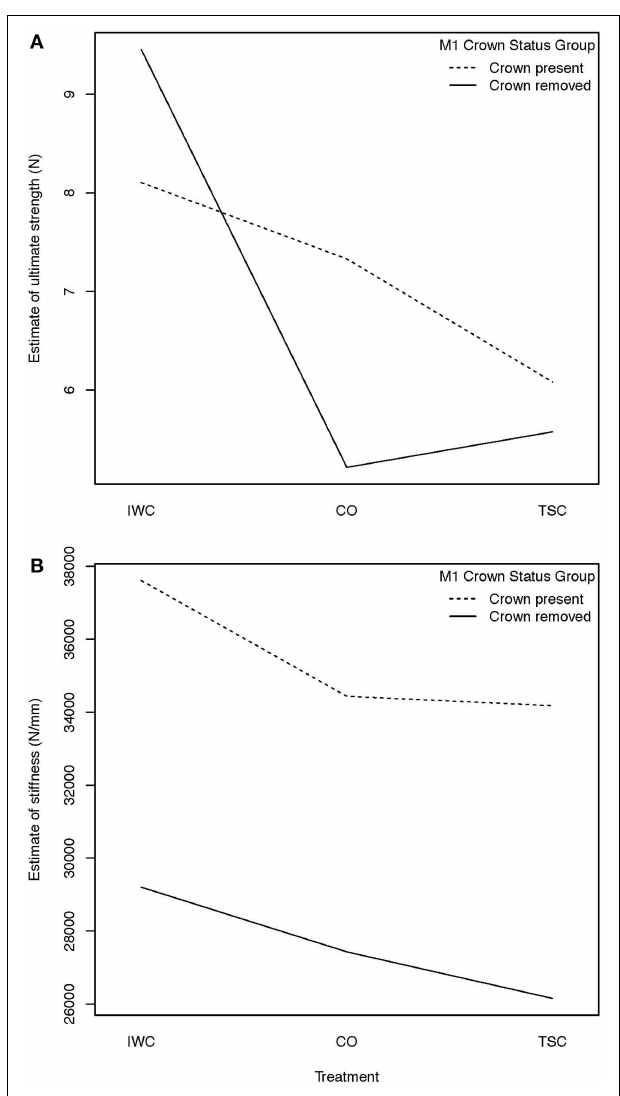
FIGURE 6 | (A) Hodges–Lehmann estimate to assess treatment interaction, treatment interaction with crown status effect on strength: an interaction from the effect of removal of the crown of M1 on ultimate strength is demonstrated by the intersection of the lines in the graph. Removal of the crown of M1 was found to result in increased mean ultimate strength of the IWC treatment and a mean decreased ultimate strength of the CO and TSC treatments. (B) Hodges–Lehmann estimate to assess treatment interaction, treatment interaction with crown status effect on stiffness: when evaluating the effect of removal of the crown of M1 on stiffness, no interaction is apparent from the absence of intersection between plots. Further statistical evaluation is necessary to demonstrate the mild (inapparent) interaction. This effect is noted when evaluating the strong effect crown status has on stiffness of the IWC and TSC